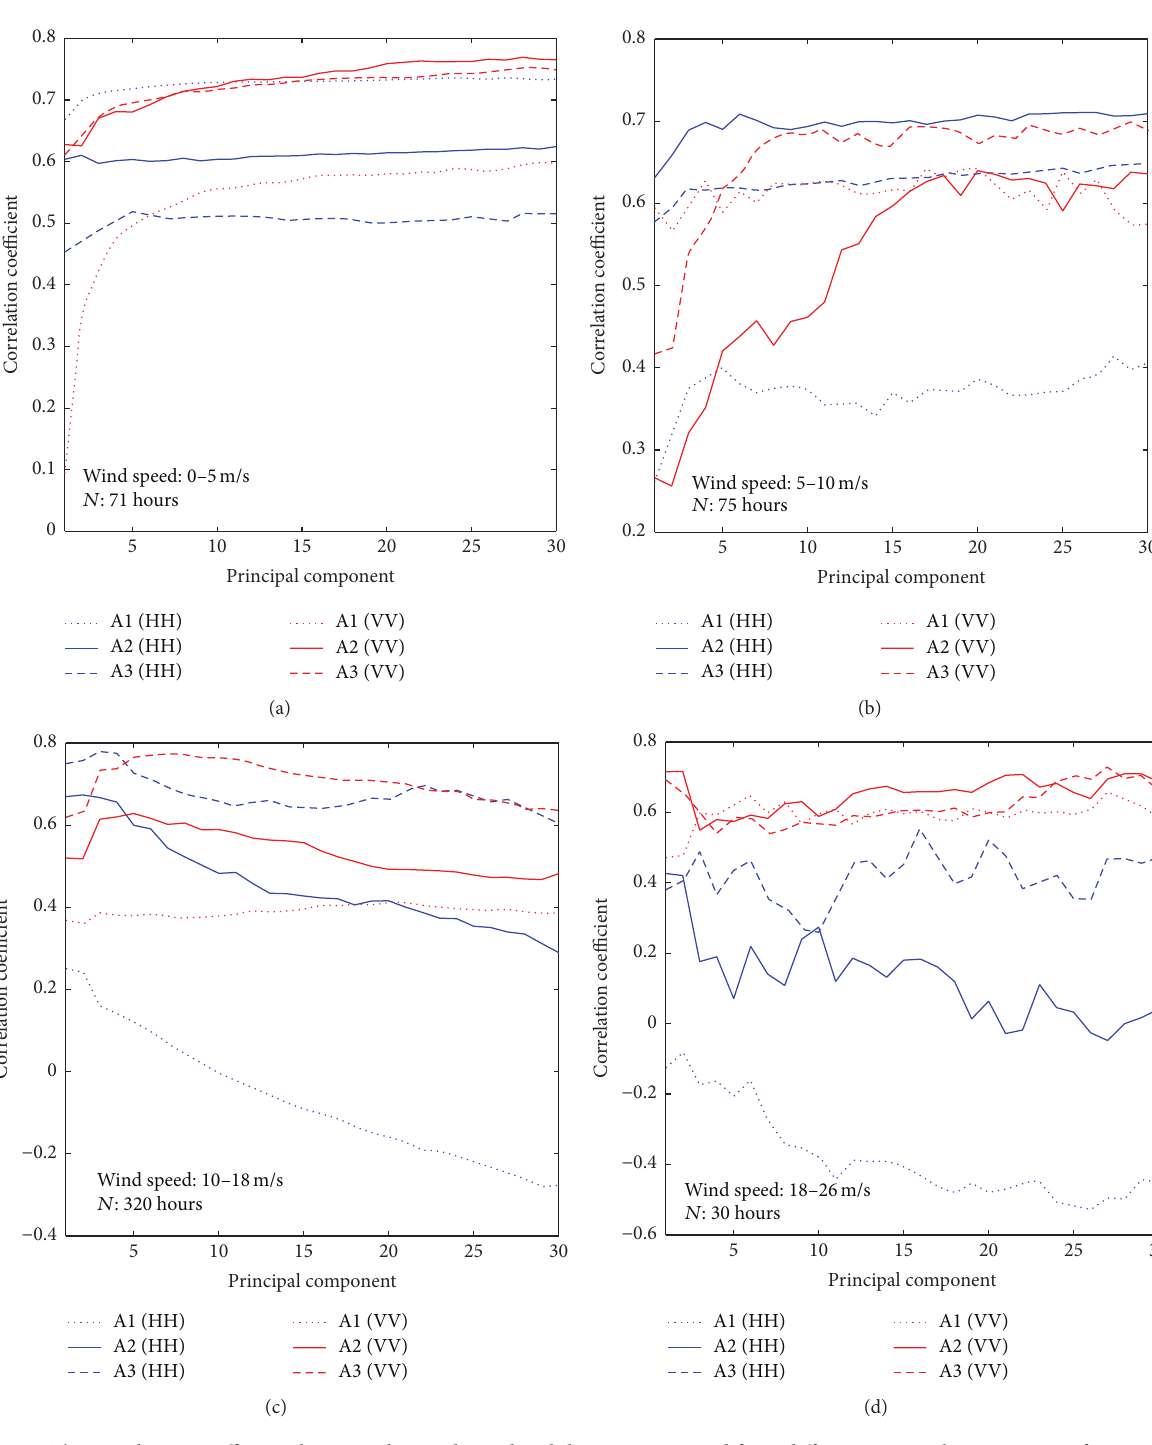
Figure 7: The correlation coefficients between the wind speed and the SWH retrieved from different principal components of HH and VV polarized X-band marine radars, at the wind speeds of (a) 0–5 m/s, (b) 5–10 m/s, (c) 10–18 m/s, and (d) 18–26 m/s. The number “ 𝑁 ” at the bottom of each panel denotes the number of hours used in the